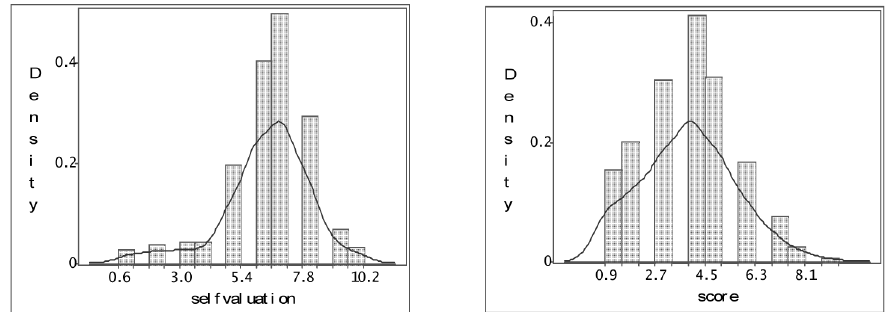
Figure 1a – Kernel density estimation for the self-valuation* * Mean = 6.4, Median = 7, Mode = 7, Stan- dard deviation = 1.7, Coefficient of variation = 26%